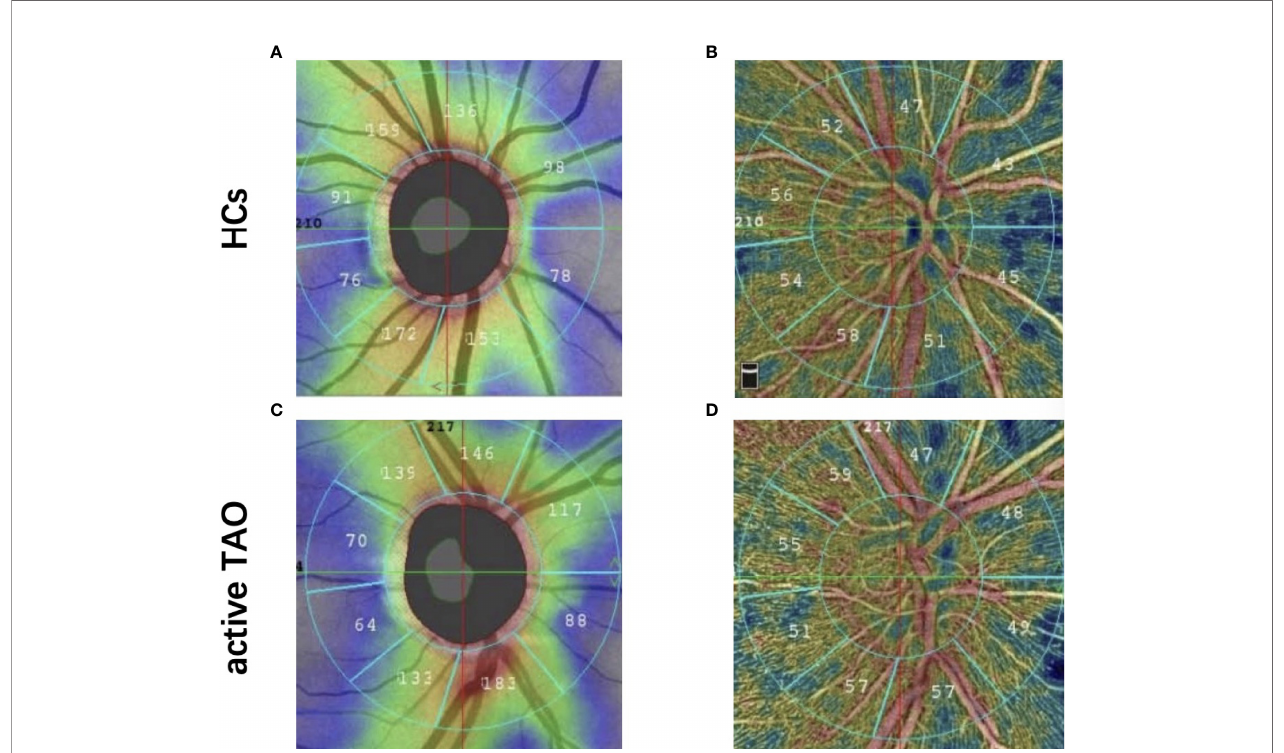
FIGURE 1 | Representative OCT-A image between two groups. Peripapillary retinal nerve fi ber layer thickness image in healthy eye (A) and active TAO (B) eyes. Optic nerve head whole image vessel density and peripapillary vessel density map in healthy eye (C) and active TAO (D) eyes.